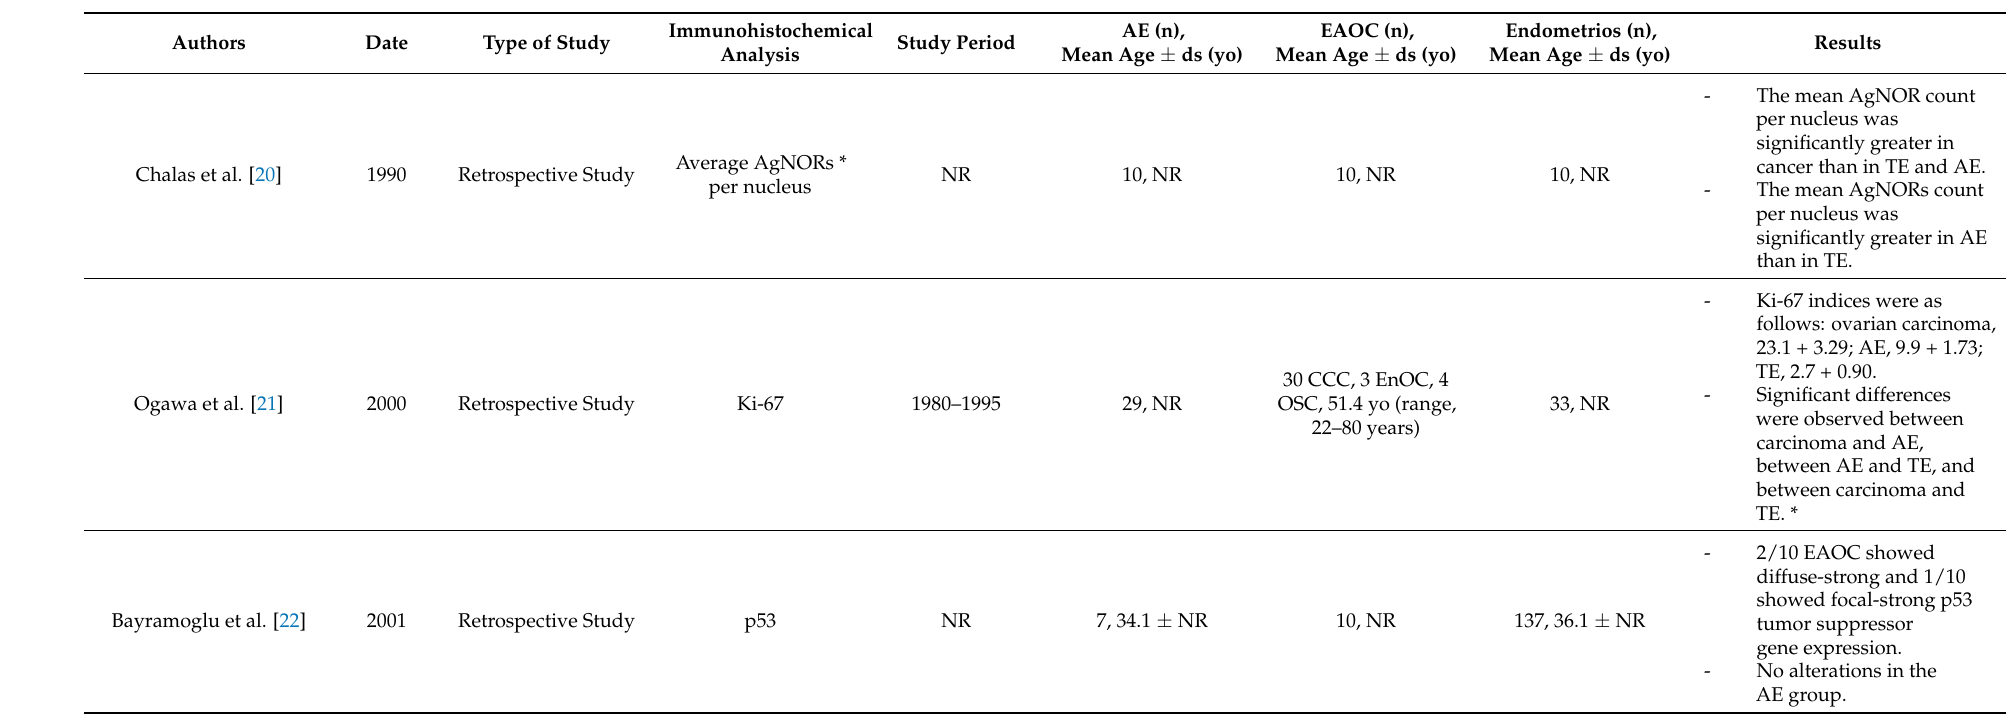
Table 1. Studies investigating molecular targets associated with atypical